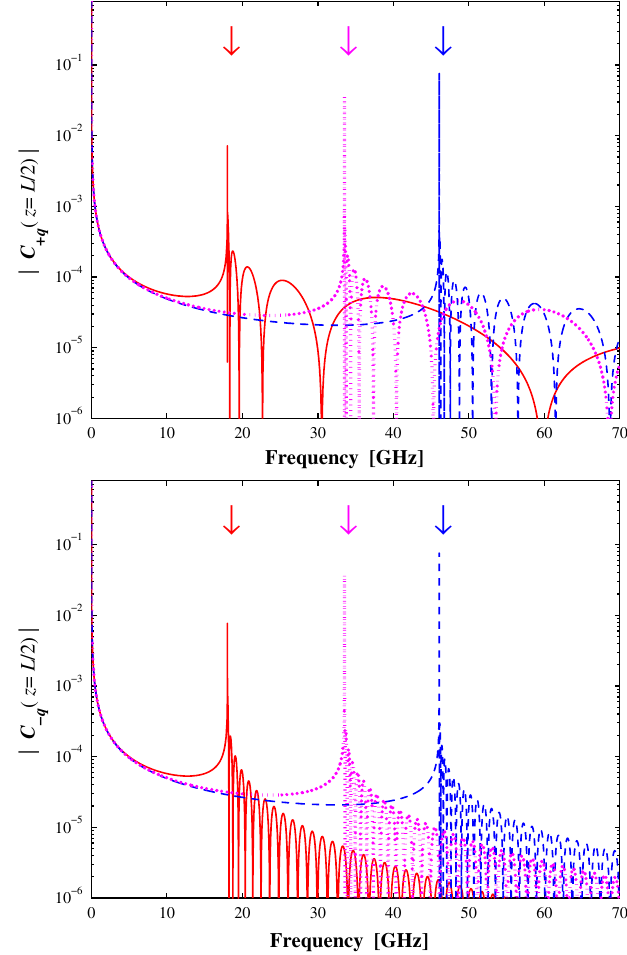
FIG. 3. (Color) Frequency dependence of the forward (top) and the backward (bottom) field amplitudes (30) found at the point z ¼ L= 2 (only the first three modes are shown). Arrows show the cutoff frequencies of the